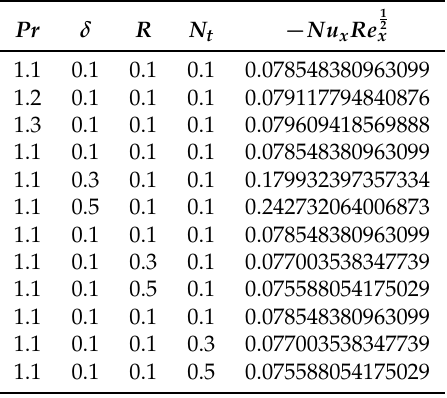
− 1 2 x for different values of selected parameters when n = 1.0, We = Table 2. The values of Nu x Re